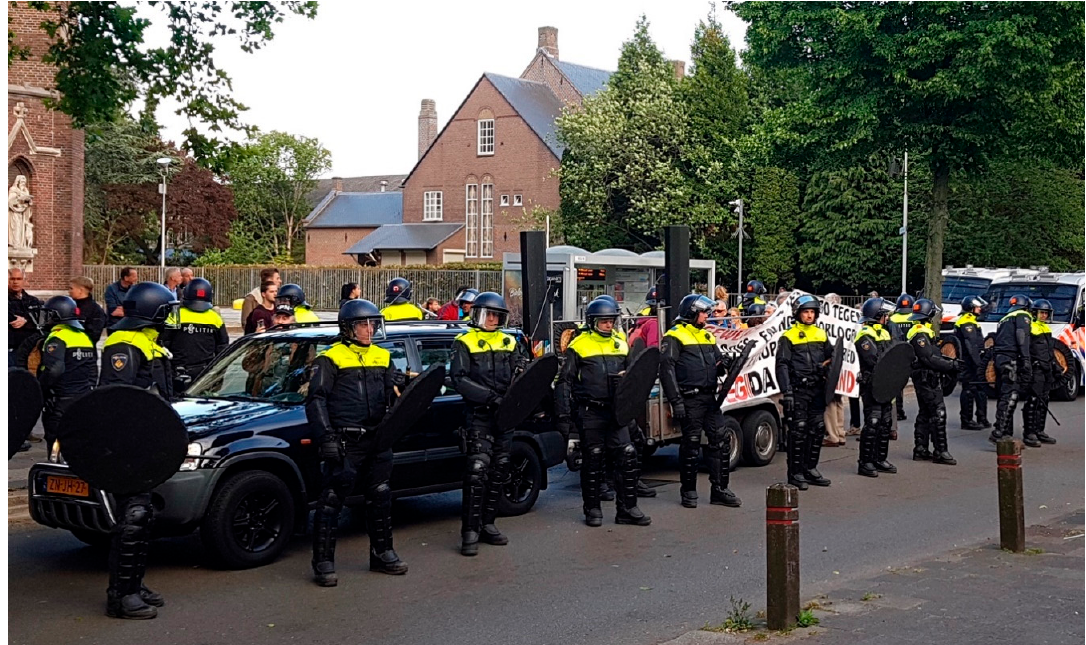
Figure 4. Pegida protesters waiting until they can proceed towards the Al-Fourqaan mosque. Photo taken by the author. taken by the